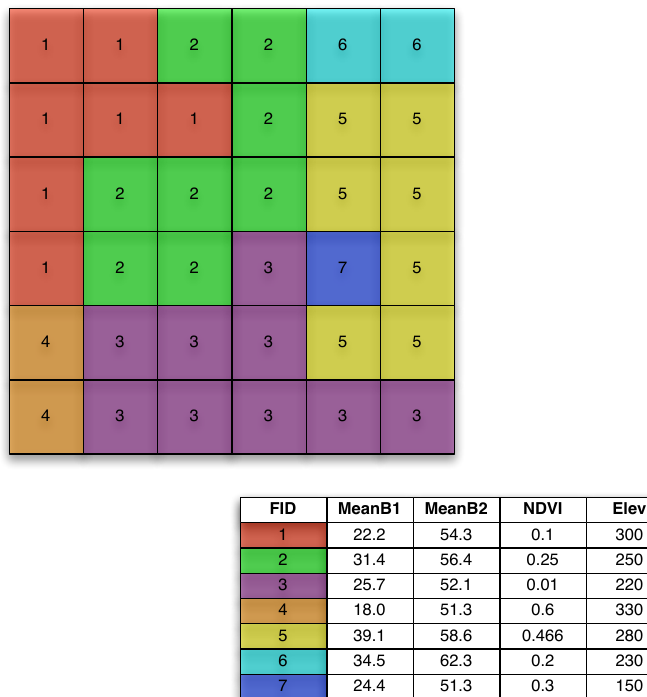
Figure 1. Example of raster clumps, used to store a represented object, and the corresponding attribute table. Each clump is linked to a row in the attribute table by the pixel values, which correspond to the clump feature ID